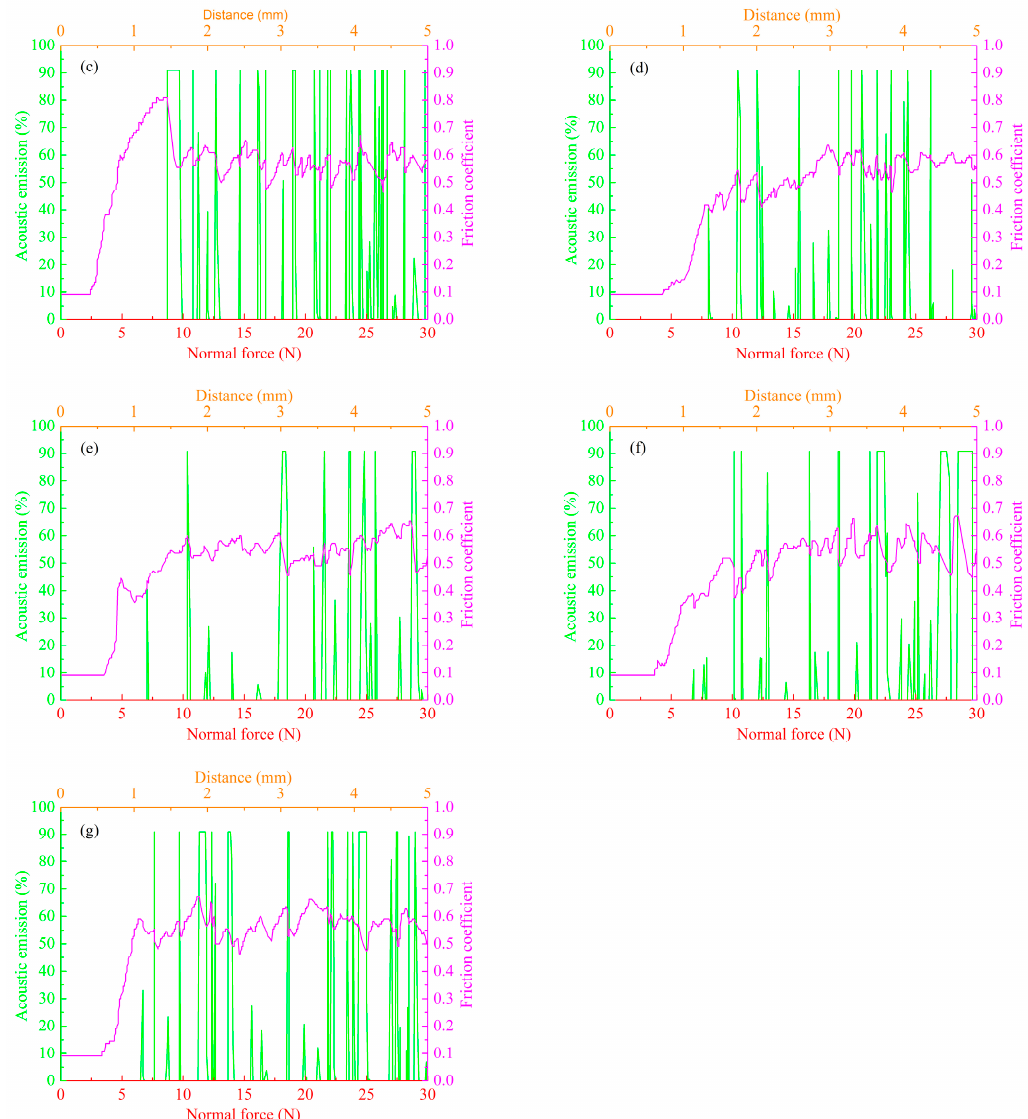
Figure 11. The supplementary data graphics of scratches on the microarc oxidation coatings formed on aluminum alloys at different anode pulse-widths. ( a ) 1000 µ s; ( b ) 1500 µ s; ( c ) 2000 µ s; ( d ) 2500 µ s; ( e ) 3000 µ s; ( f ) 3500 µ s; ( g ) 4000 µ s.